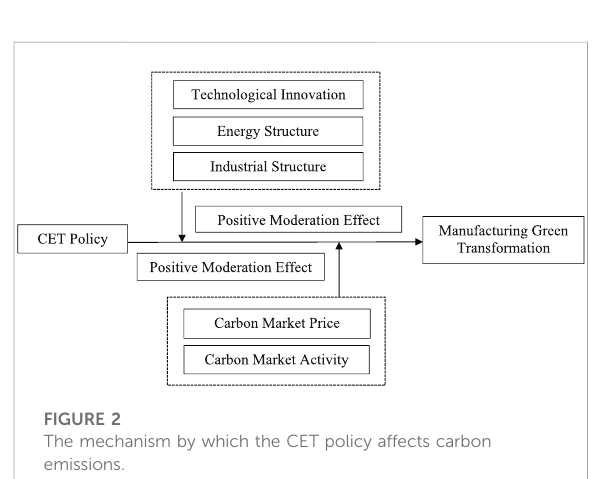
FIGURE 2 The mechanism by which the CET policy affects carbon emissions.